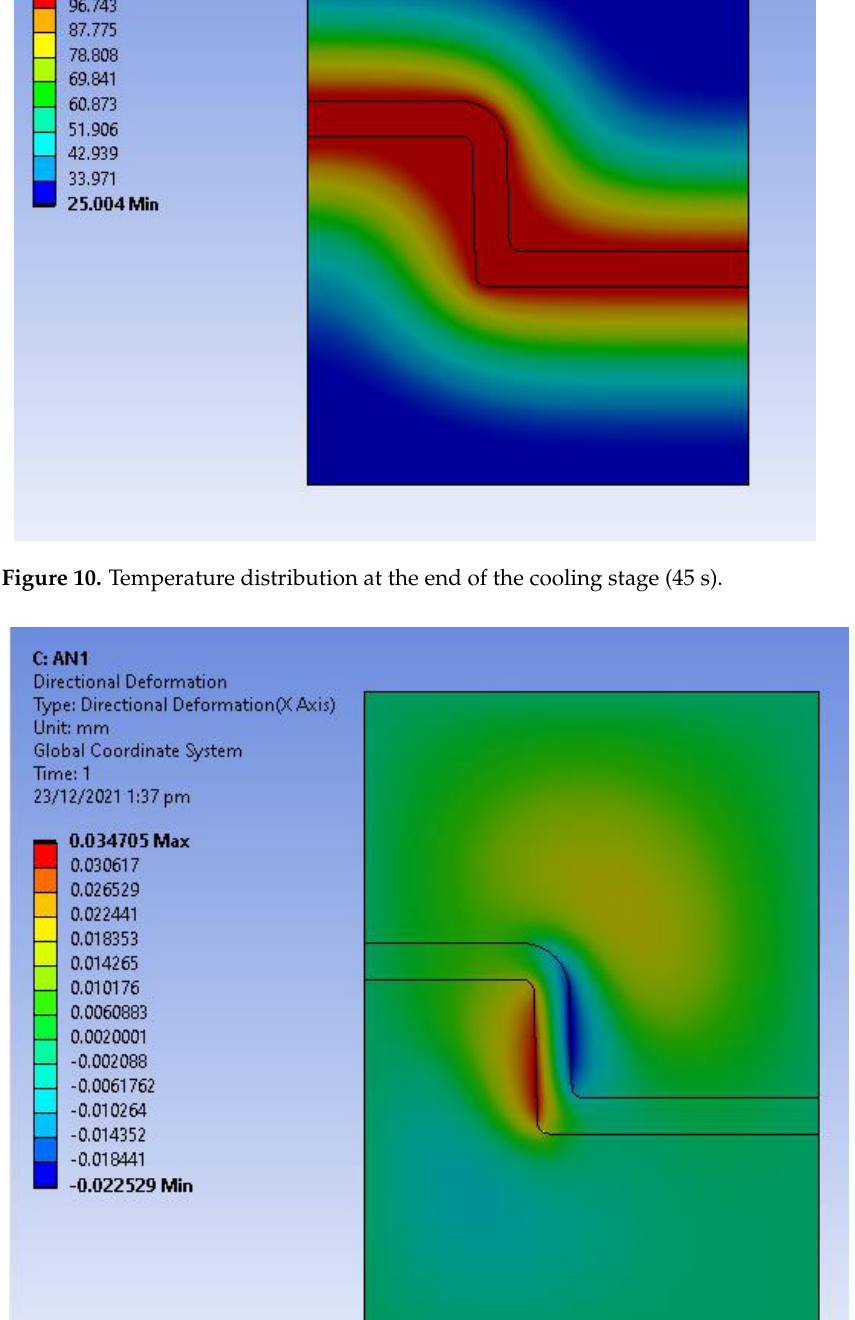
Figure 12. Directional deformation in Y-axis at 45 s (expansion of tool and shrinkage of part during cooling stage).